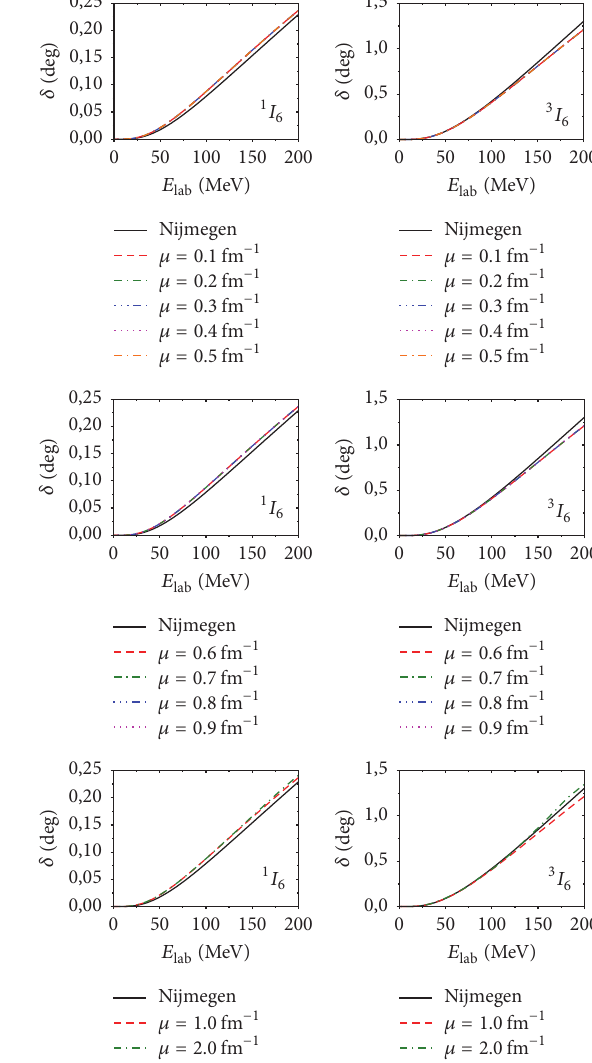
Figure 9: (Color on-line) phase shifts in 1 𝐻 5 and 3 𝐻 5 channels calculated from the solution of the subtracted LS equation for the 𝐾 -matrix with five subtractions for the N3LO-EGM potential for several values of the renormalization scale compared to the Nijmegen partial wave analysis.